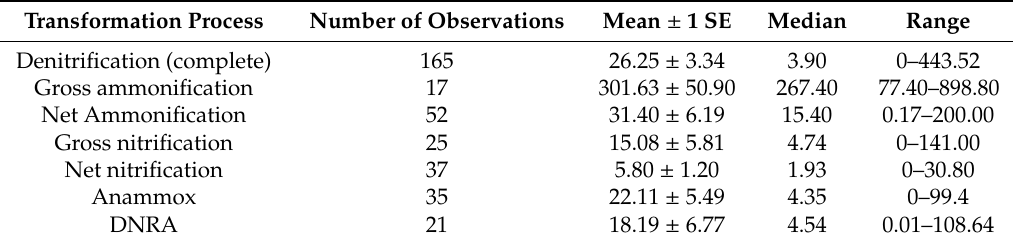
Table 3. Rates of N transformation processes (mg N m − 2 d − 1 ) in mangrove soils. All rates are to soil depths of 5–20 cm. Rates presented on a g − 1 DW / WW basis were converted to m − 2 assuming 1 g soil =